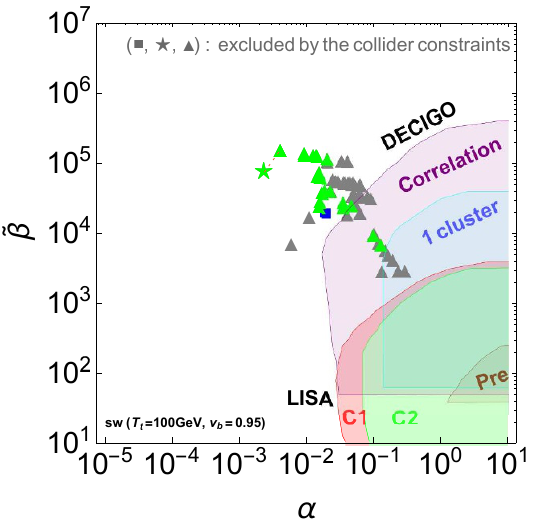
Figure 4 . Predicted values of α and β for the benchmark point m X = 200 GeV and g X = 2 ( v S = 100 GeV). For two-step PT with 1st order 1st order, the former (green closed star) and → e the latter (green closed triangle) is connected with a red dashed line. Parameter sets excluded by the collider bounds shown in figure 3 are marked with darker points. The expected sensitivities of LISA and DECIGO detector designs are computed by using the sound wave contribution for T t = 100 GeV and v b = 0 .